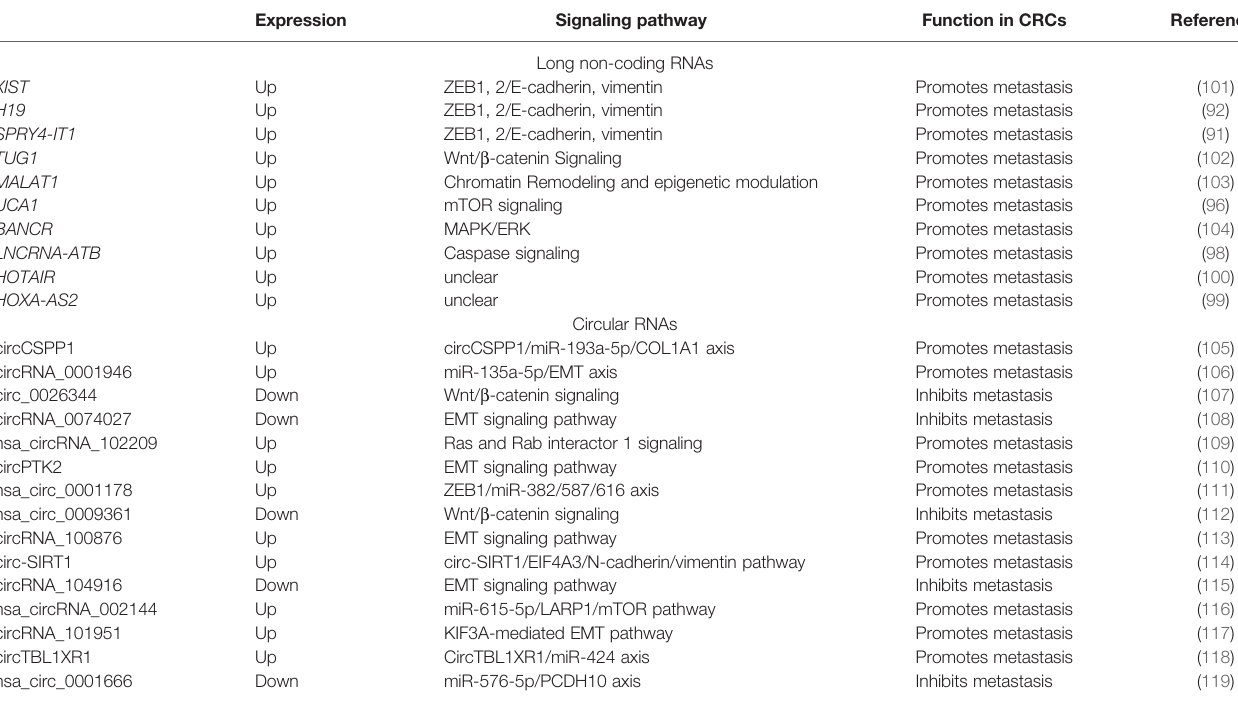
TABLE 2 | Role of long non-coding RNAs (lncRNAs) and circular RNAs (circRNAs) associated with epithelial – mesenchymal transition (EMT) in colorectal cancers